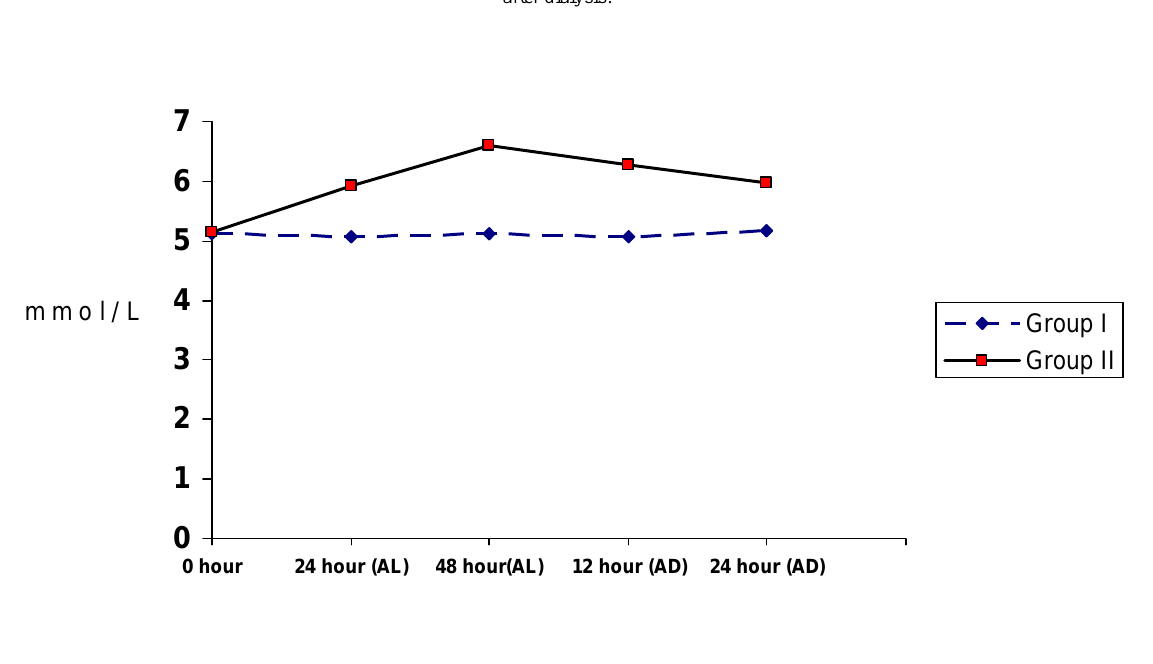
FIGURE 5. (SERUM POTASSIUM): Showing the serum potassium (mmol/L) level at different time interval. AL = after ligation, AD = after dialysis